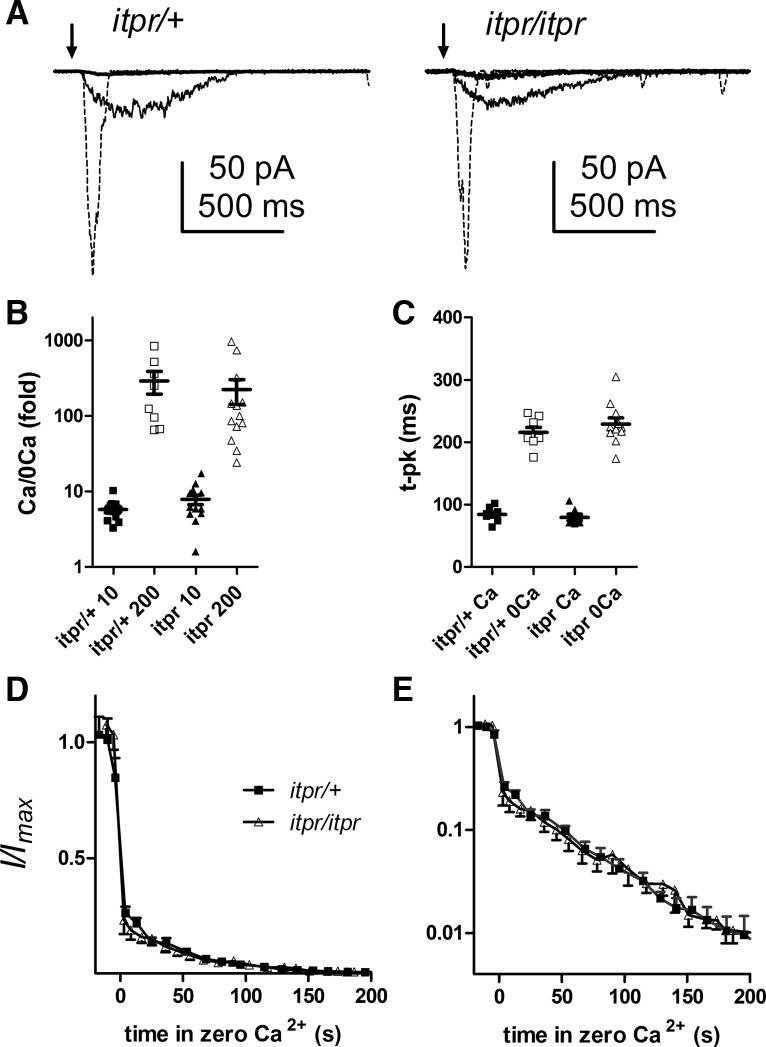
Effects of Ca2+-free perfusion in itpr-null photoreceptors are similar to those of controls. A, Responses to brief flashes containing ∼25 effective photons recorded with EGTA-buffered electrode solutions before (dotted traces), 10 s after (larger slow responses), and 200 s after perfusing with Ca2+-free solution (1 mm EGTA). B, C, The reduction in peak amplitude (log10 scale) after 10- and 200-s perfusion and slowing of the response (measured by time to peak after 10- to 60-s perfusion) were similarly affected in itpr-null mosaic and itpr/+ sibling controls (p = 0.2–0.7, two-tailed t tests). D, Time course of suppression of the light response in Ca2+-free solution was similar in itpr-null mosaics and controls (mean ± SEM, n = 9–12 cells). E, Same data plotted on log10 scale.